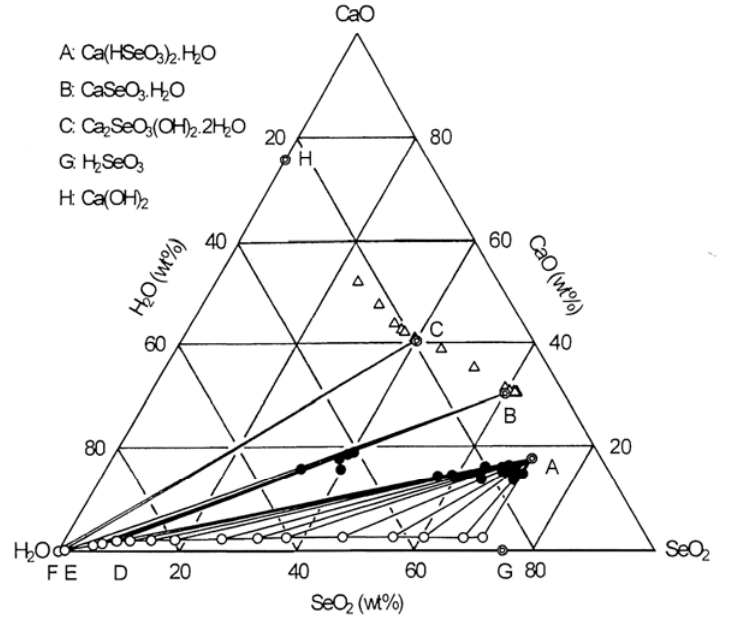
-H O system at 25 2 2